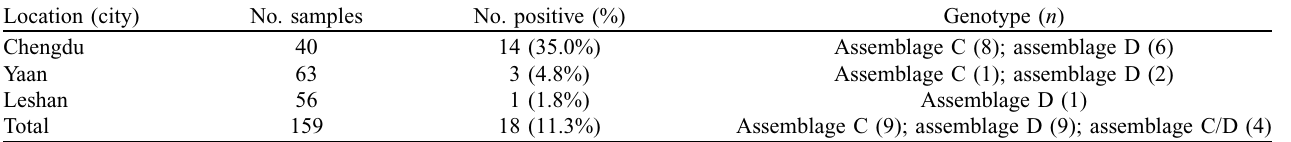
Table 1. Prevalence and distribution of Giardia duodenalis by location in Sichuan province, China. Location (city)